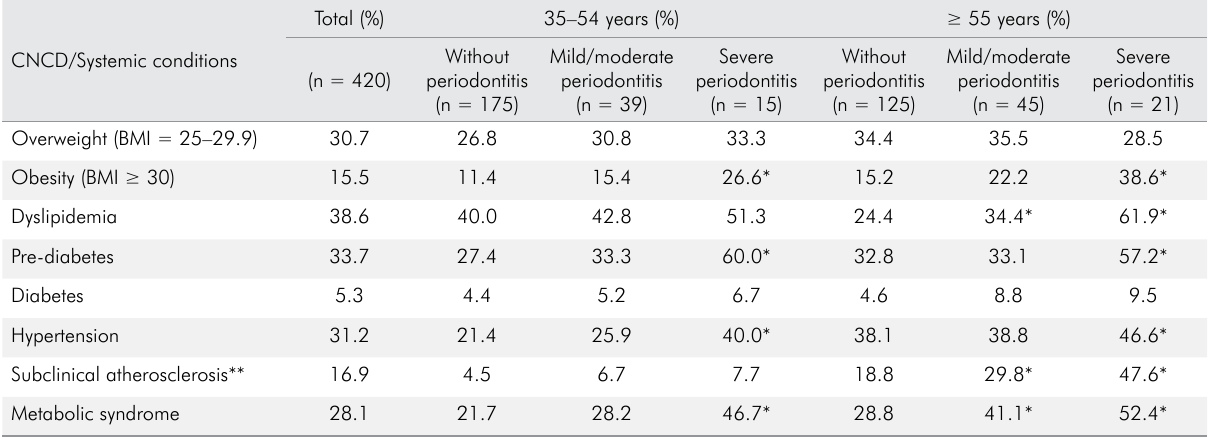
Table 4. Prevalence of chronic noncommunicable diseases (CNCD) and systemic conditions according to age group and presence of periodontitis. Advento study. Sao Paulo, 2016.